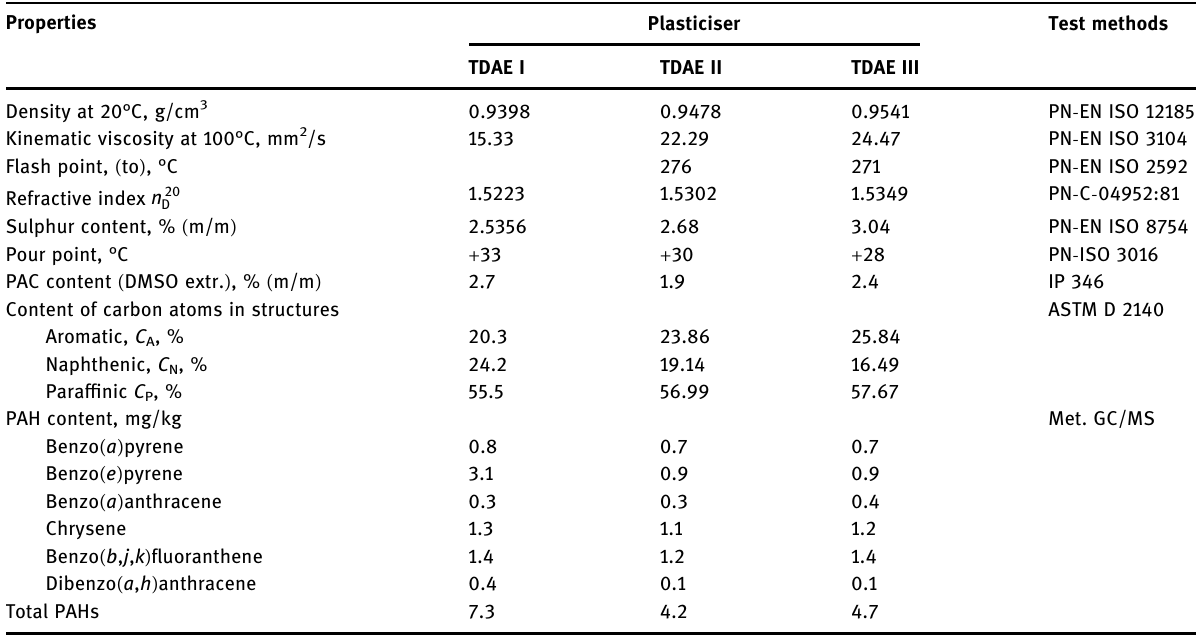
Table 3: Physiochemical properties of TDAE